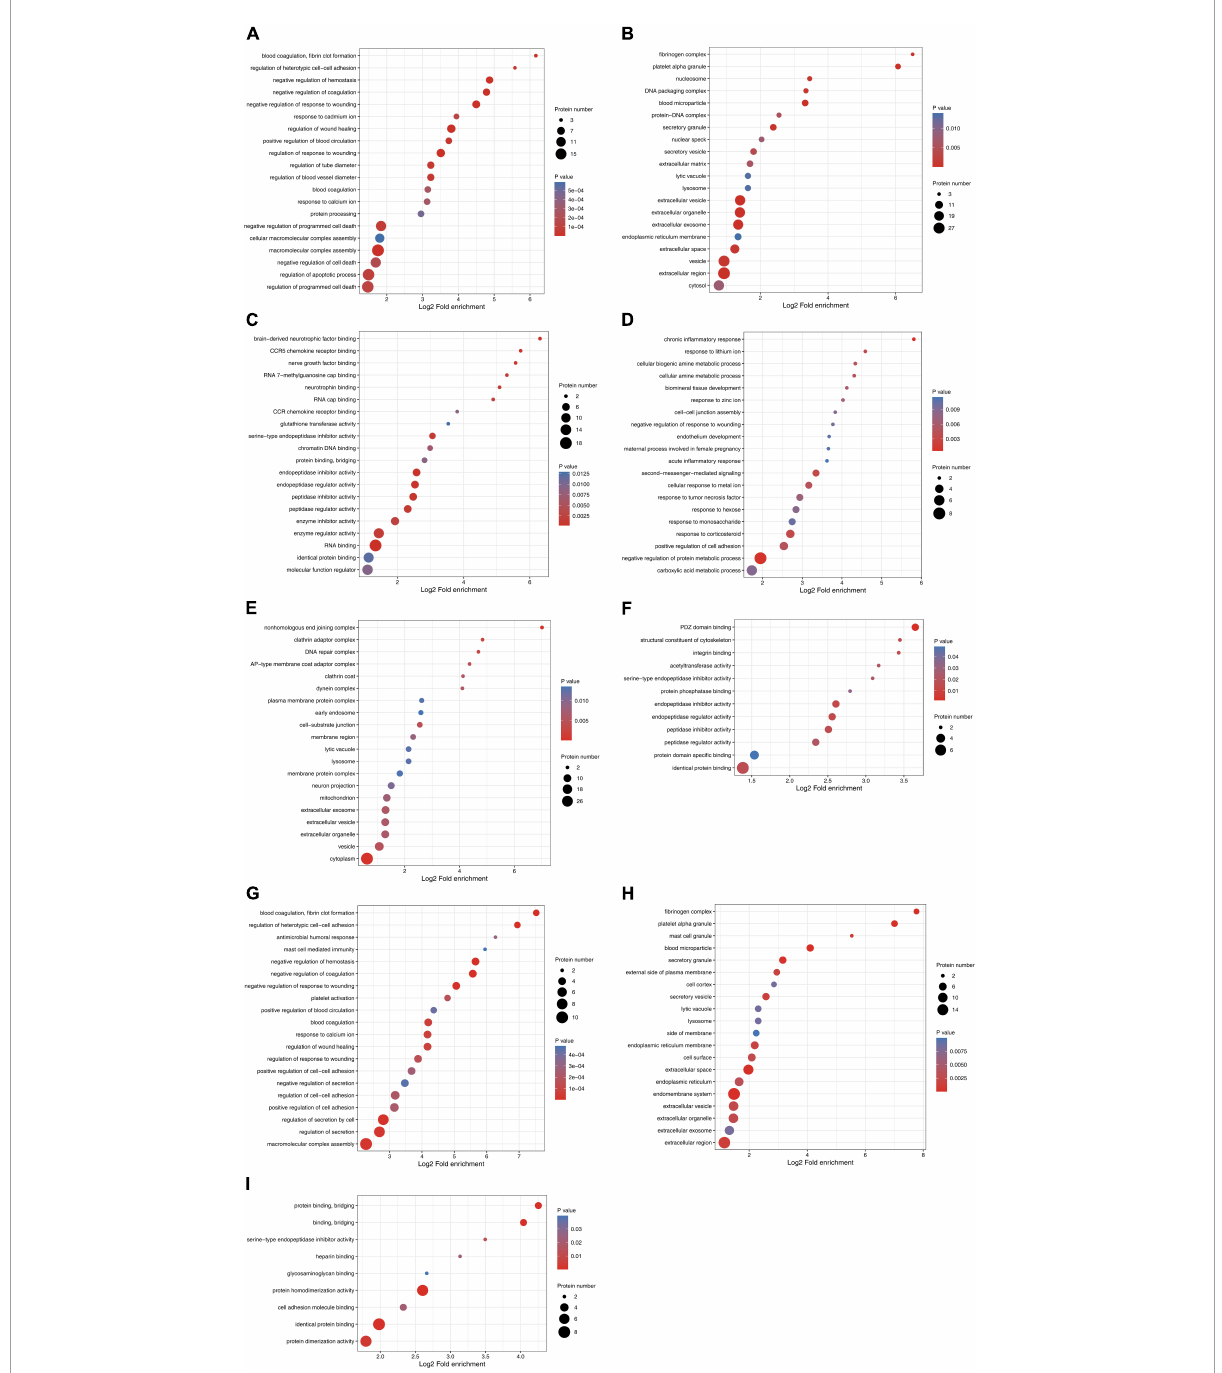
FIGURE2 Functional enrichment and cluster analysis of differentially expressed proteins in hippocampus in lithium-pilocarpine induced acute epileptic rat. (A) GO “biological process” enrichment of differentially expressed proteins on Day 1 comparing with control (ctrl) in hippocampus. (B) GO “cellular component” enrichment of differentially expressed proteins on Day 1 comparing with control (ctrl) in hippocampus. (C) GO “molecular function” enrichment of differentially expressed proteins on Day 1 comparing with control (ctrl) in hippocampus. (D) GO “biological process” enrichment of differentially expressed proteins on Day 3 comparing with control (ctrl) in hippocampus. (E) GO “cellular component” enrichment of differentially expressed proteins on Day 3 comparing with control (ctrl) in hippocampus. (F) GO “molecular function” enrichment of differentially expressed proteins on Day 3 comparing with control (ctrl) in hippocampus. (G) GO “biological process” enrichment of differentially expressed proteins on Day 3 comparing with Day 1 in hippocampus. (H) GO “cellular component” enrichment of differentially expressed proteins on Day 3 comparing with Day 1 in hippocampus. (I) GO “molecular function” enrichment of differentially expressed proteins on Day 3 comparing with Day 1 in